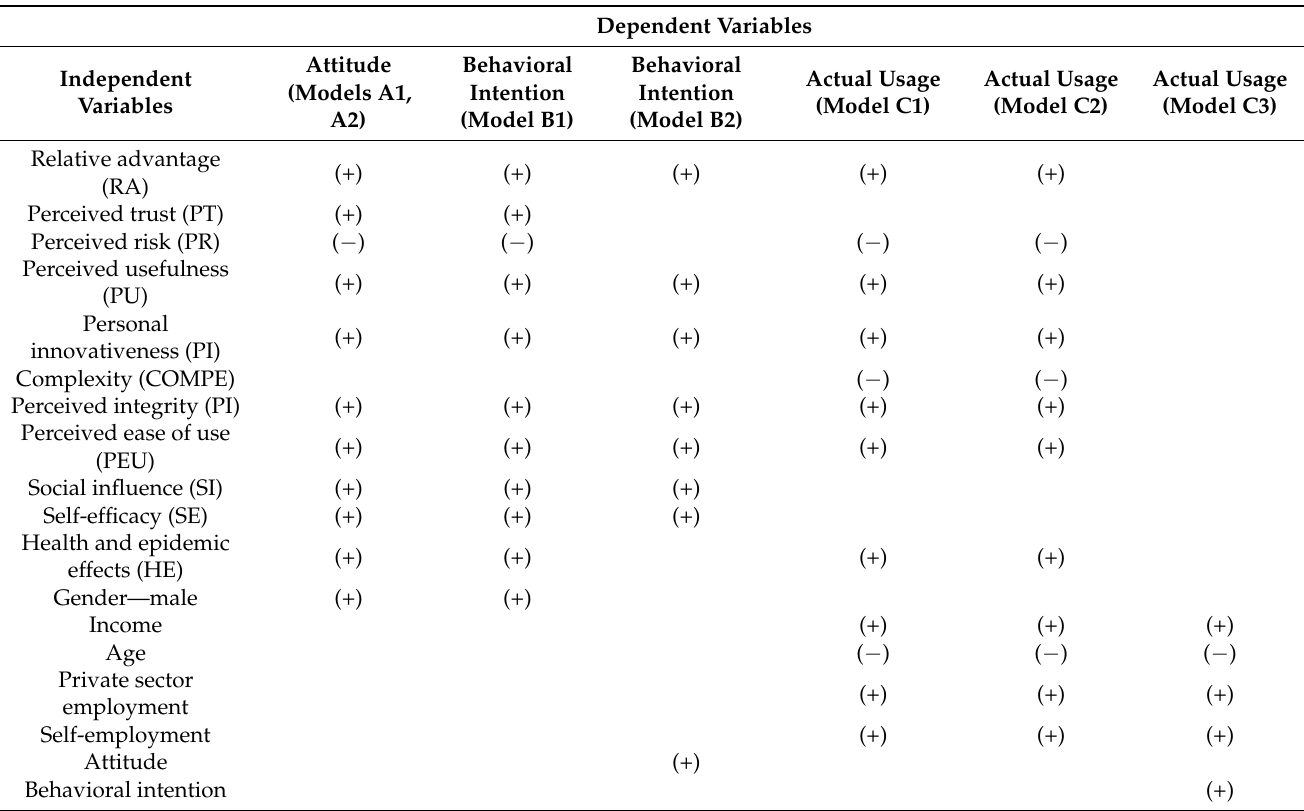
Table 9. Summary